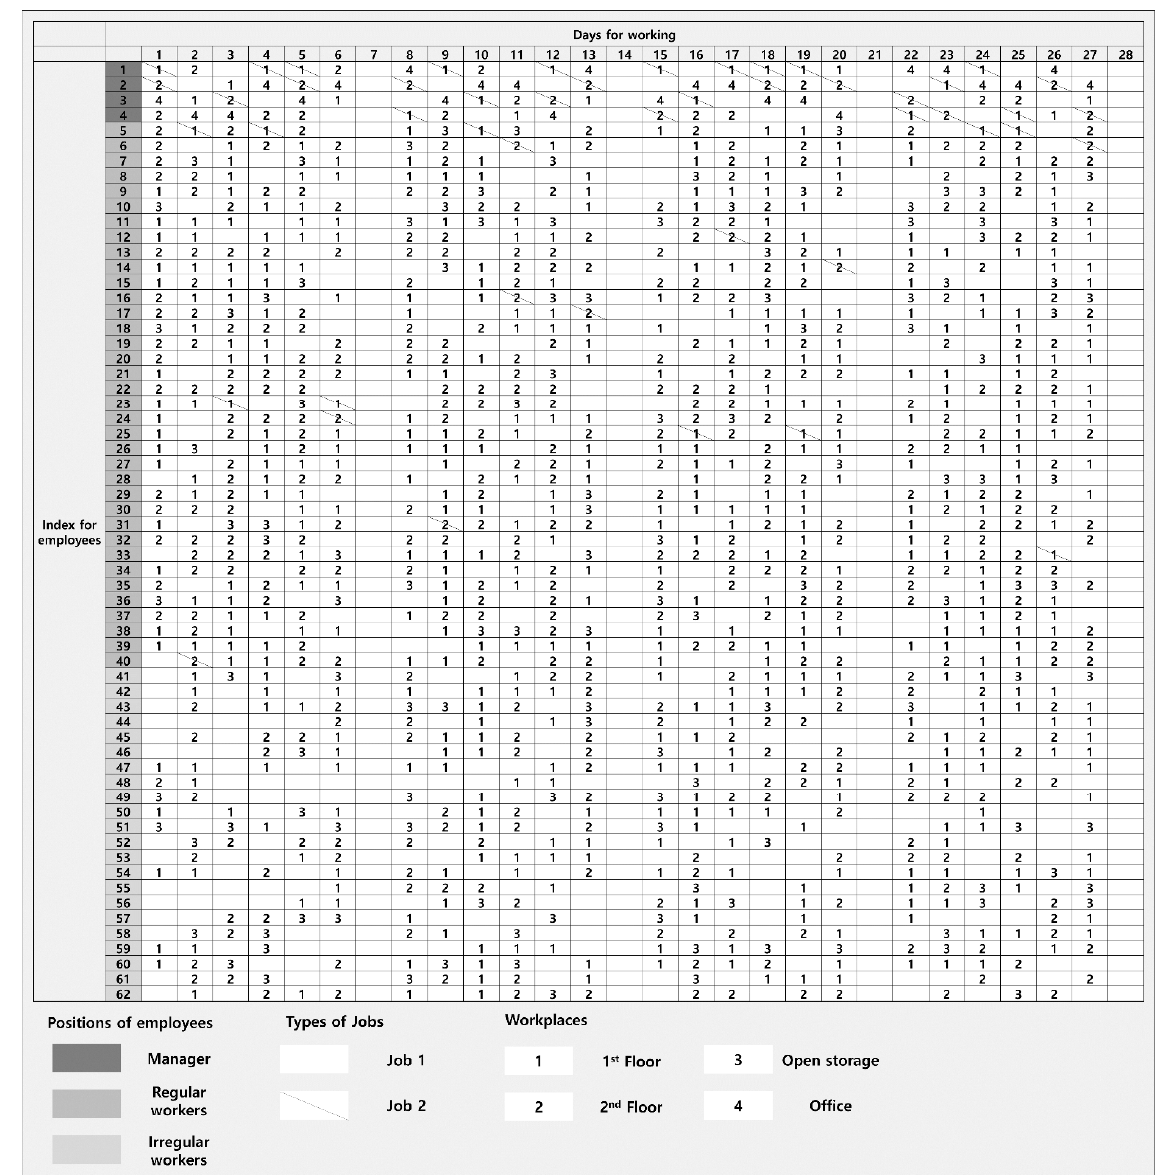
Figure 4. Optimal staff schedule during daytime.